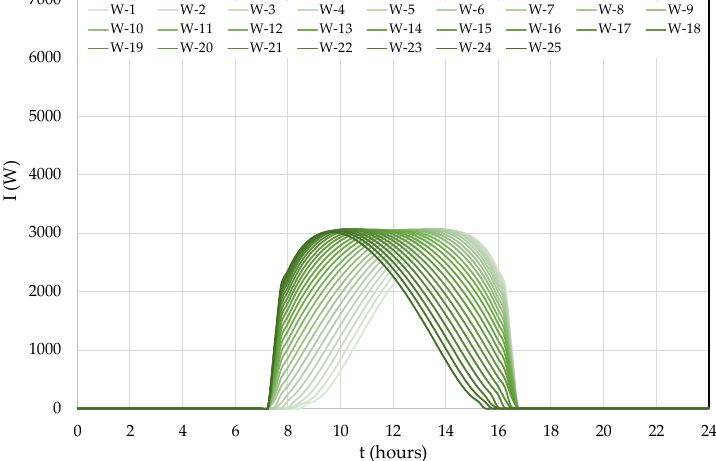
Figure 20. Evolution of transmi tt ed solar radiation for the di ff erent smooth DSF glass components (Case F).